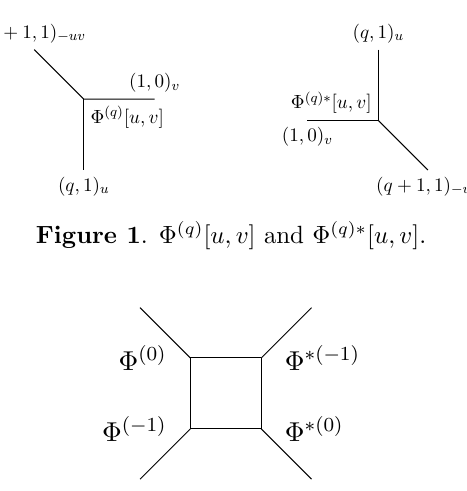
Table 1 . Con(cid:12)guration of branes in the brane web construction. Bar represents the direction branes stretch along, and dot means the point-like direction for branes. General 5-branes lie as a line in the 5{6 plane, and the web diagram encodes all these information on the 5{6 plane.